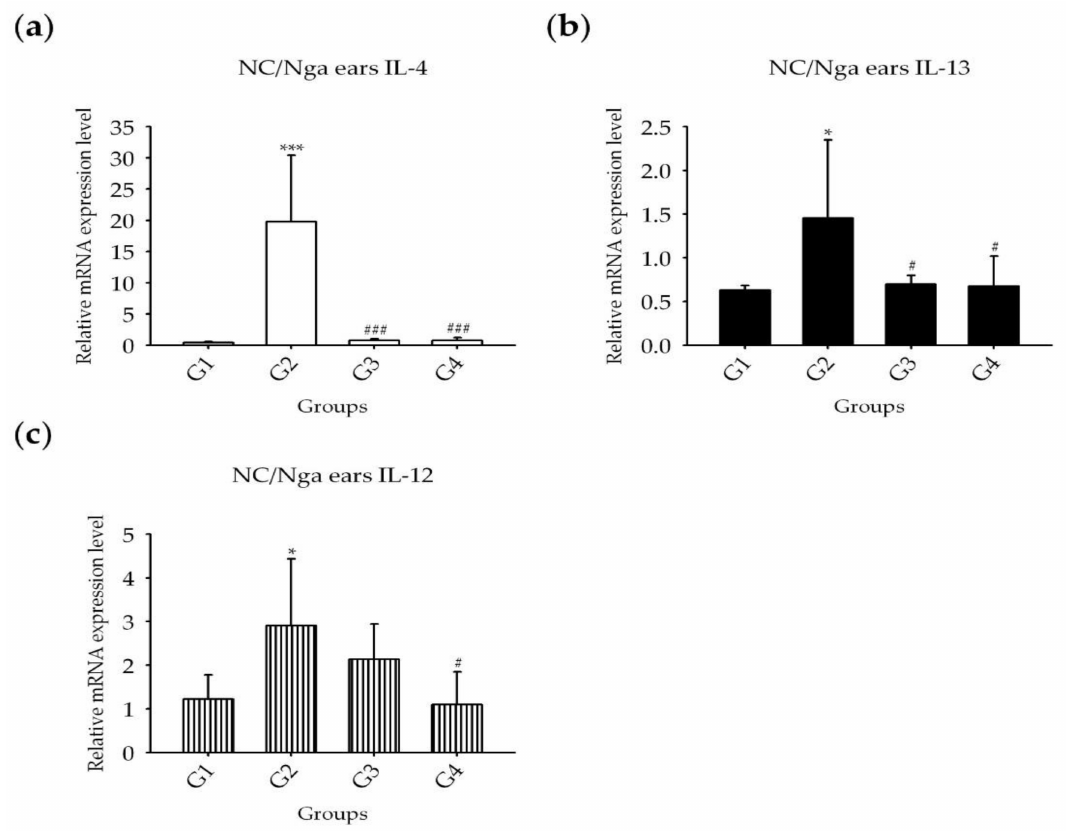
Figure 11. Expression of inflammatory cytokines in the ears of NC / Nga mice analyzed by RT-qPCR. ( a ): Level of IL-4; ( b ): level of IL-13; ( c ): level of IL-12. G: negative control group; G2: positive control group (HDM only); G3: drug control (0.1% Hc); G4: 1% ASex. All groups were induced with